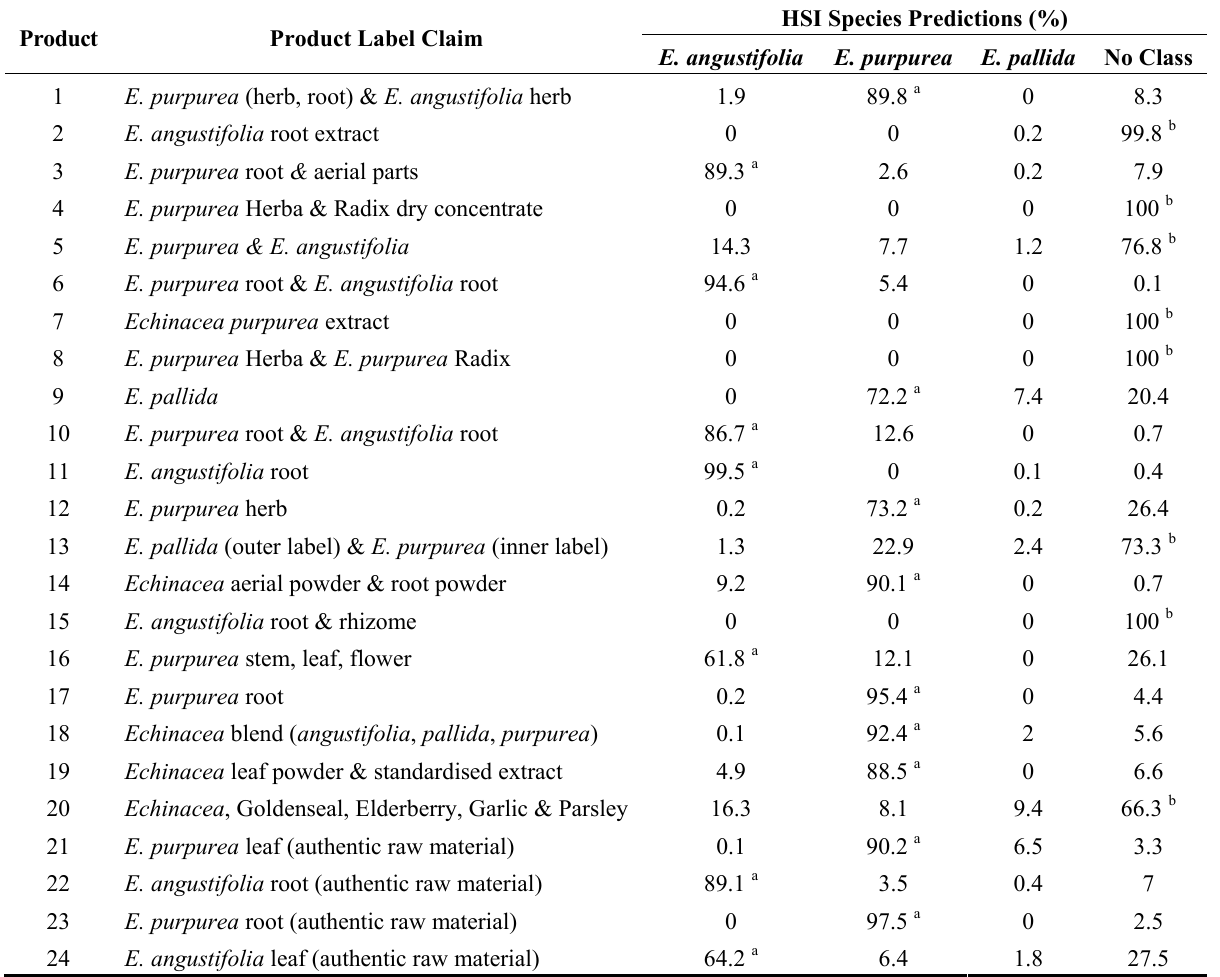
Table 1. Results of the HSI classification analysis using the (PLS-DA) model in comparison to the product